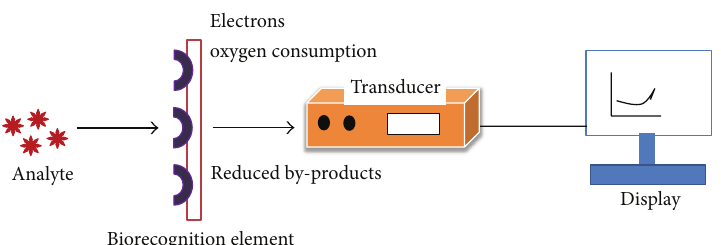
Figure 1: Basic principle of electrochemical biosensor.